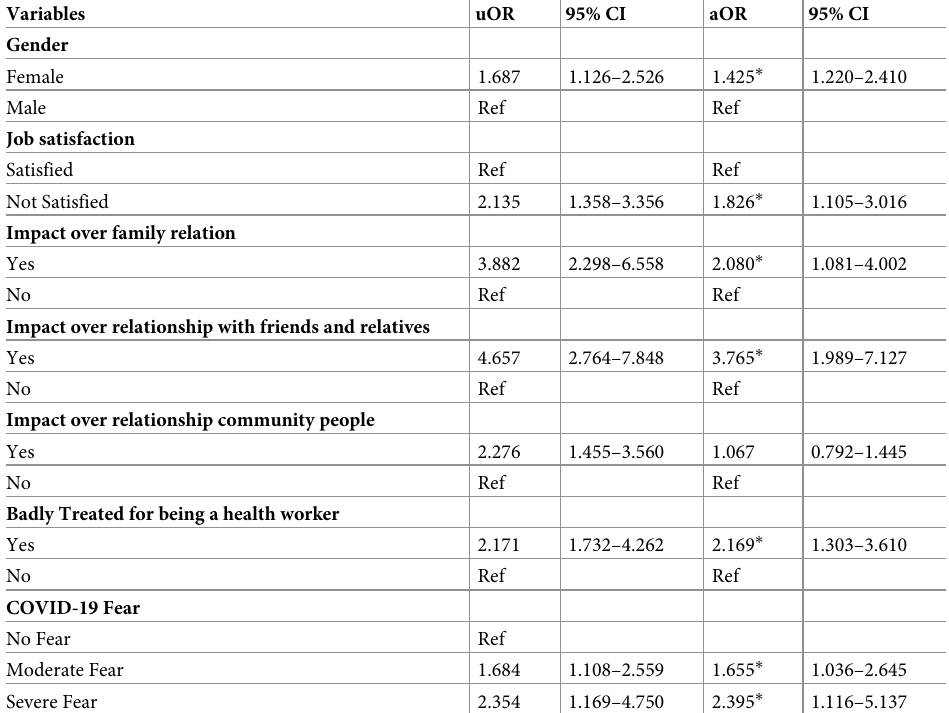
The participants also reported to have experienced different forms of discrimination from the family as well as community people. During the interviews, some of the health profession- als shared how they were maltreated by their landlords, community people and even local lead- ers during the time of COVID-19. Table 7. Predictors of depression among health